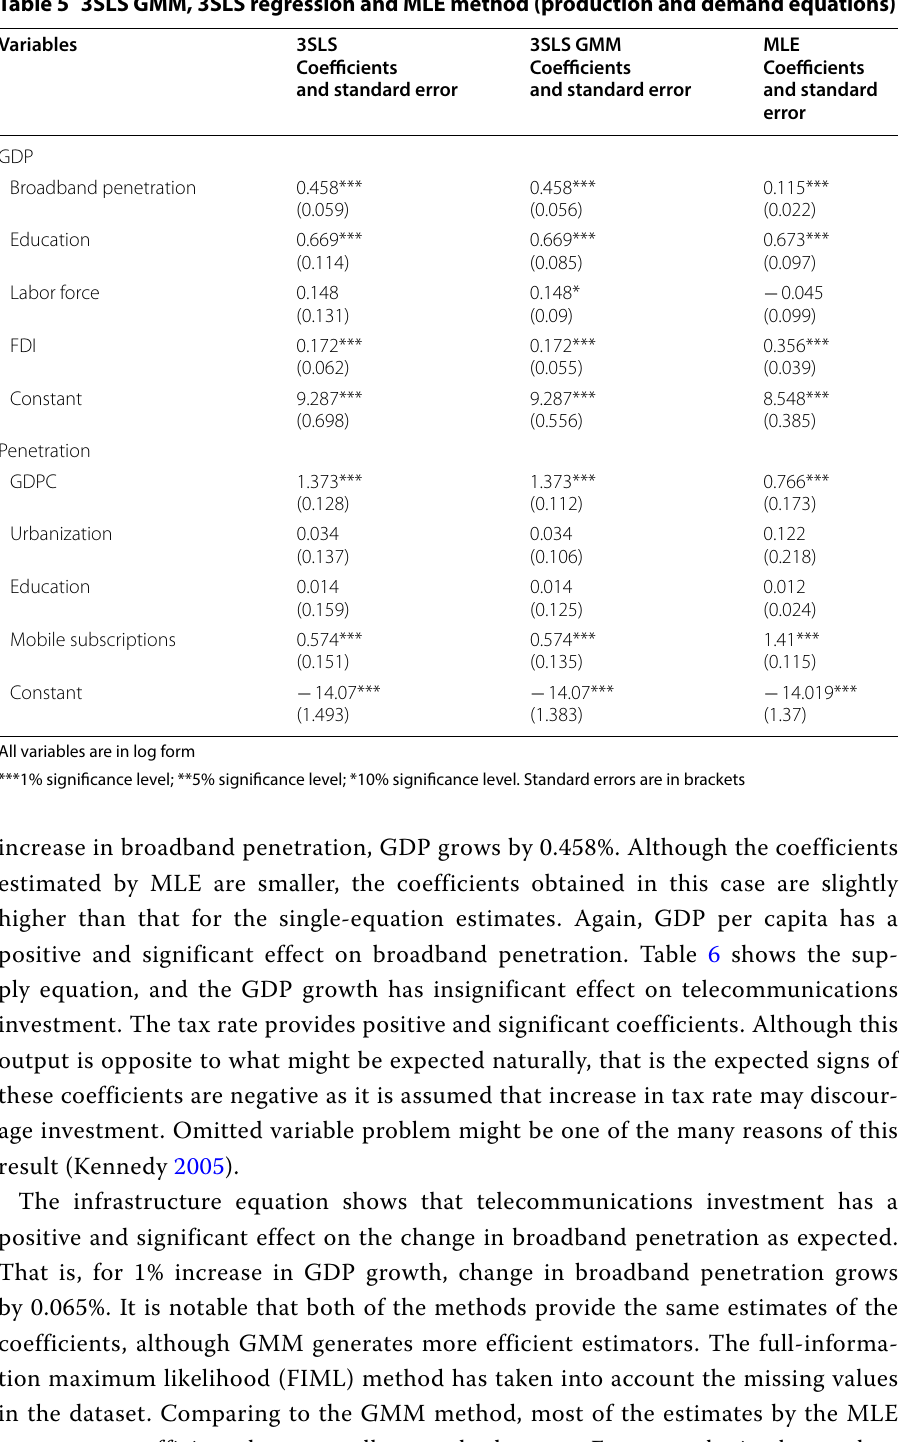
Table 5 3SLS GMM, 3SLS regression and MLE method (production and demand equations)